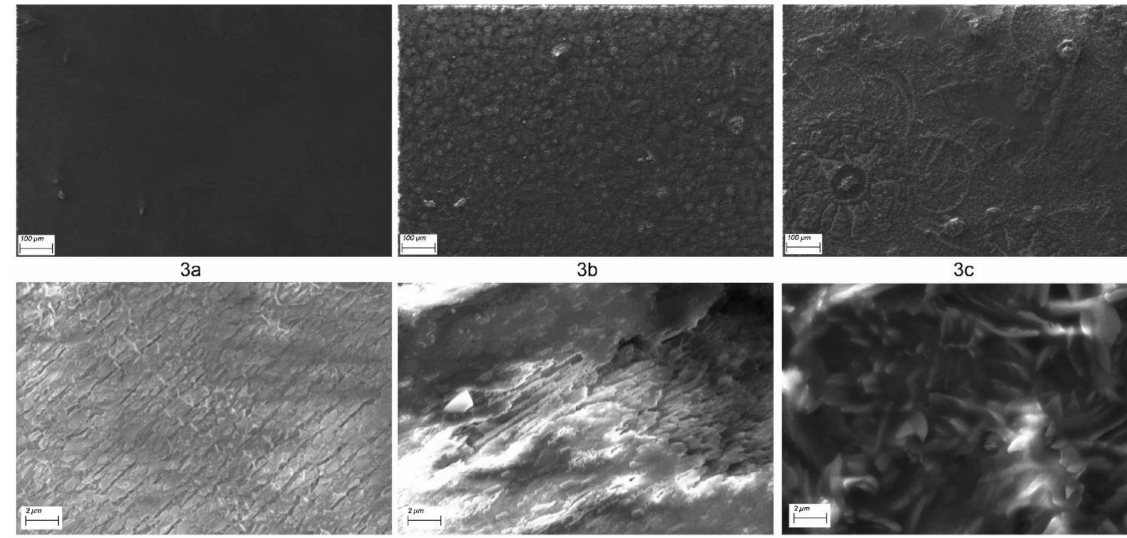
Figure 3. SEM images of the aminocarbene complexes thin films ( 3a = 2-pyridyl; 3b = 3-pyridyl; 3c = 4-pyridyl derivative) at 100 × and 5000 × .